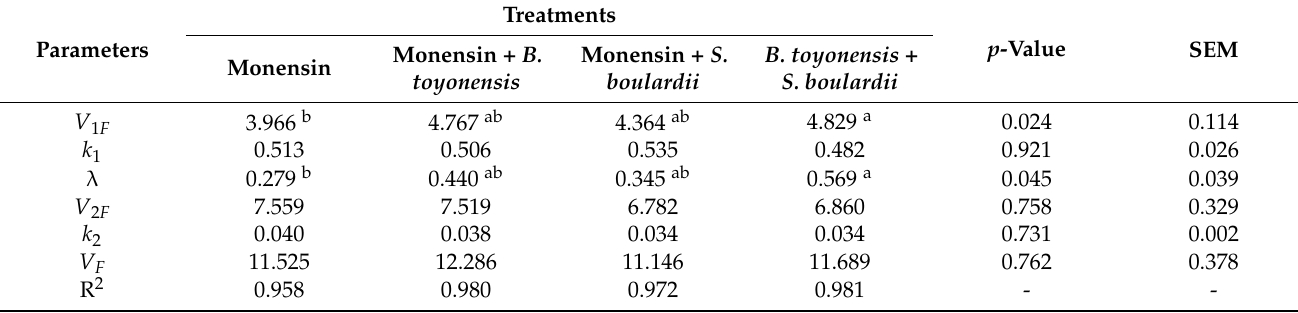
Table 5. Estimation of in vitro gas production parameters of corn silage with different feed additive combinations obtained by the Dual-pool Logistic model.